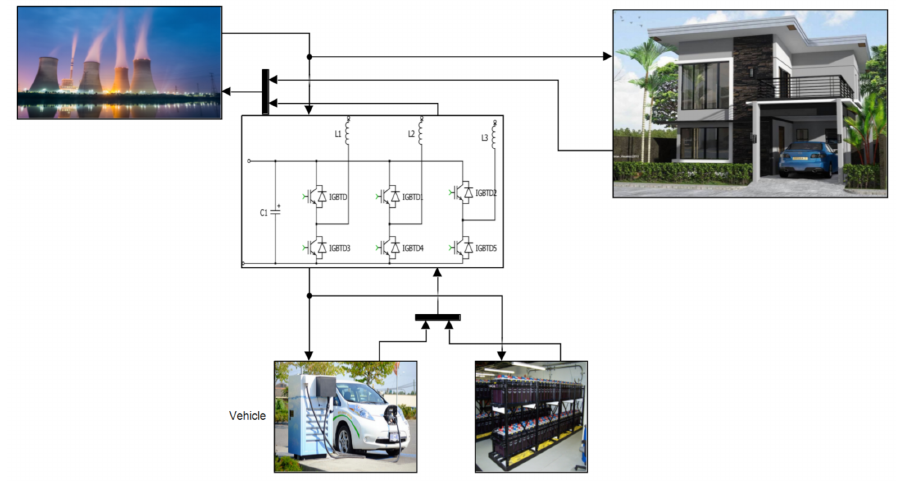
Figure 1. Block diagram of the modelled system.